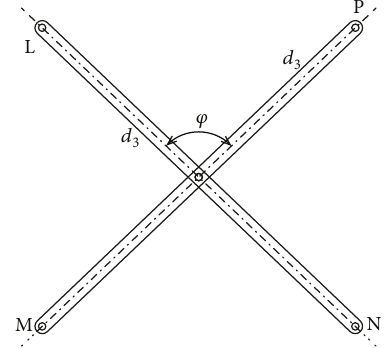
Figure 6: Scissor elements without a folding